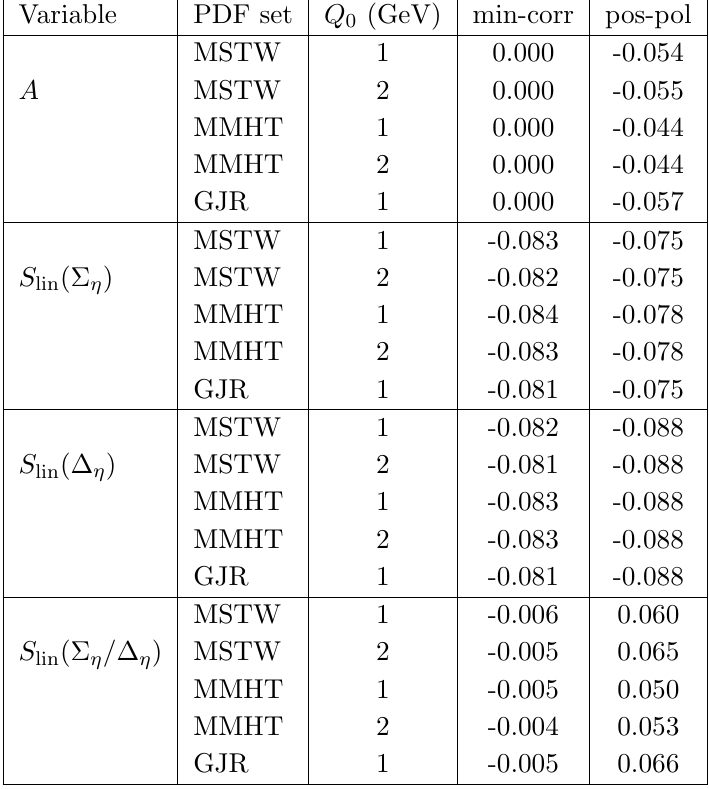
Table 5 . Results for the asymmetry A and the slopes of linear (cid:12)t to three correlation sensitive observables, for di(cid:11)erent Q 0 and PDF sets. For simplicity, the values are calculated using the narrow-width approximation, which causes little numerical di(cid:11)erences between the MSTW ( Q 0 = 1 GeV) and the \Baseline PL" values of table